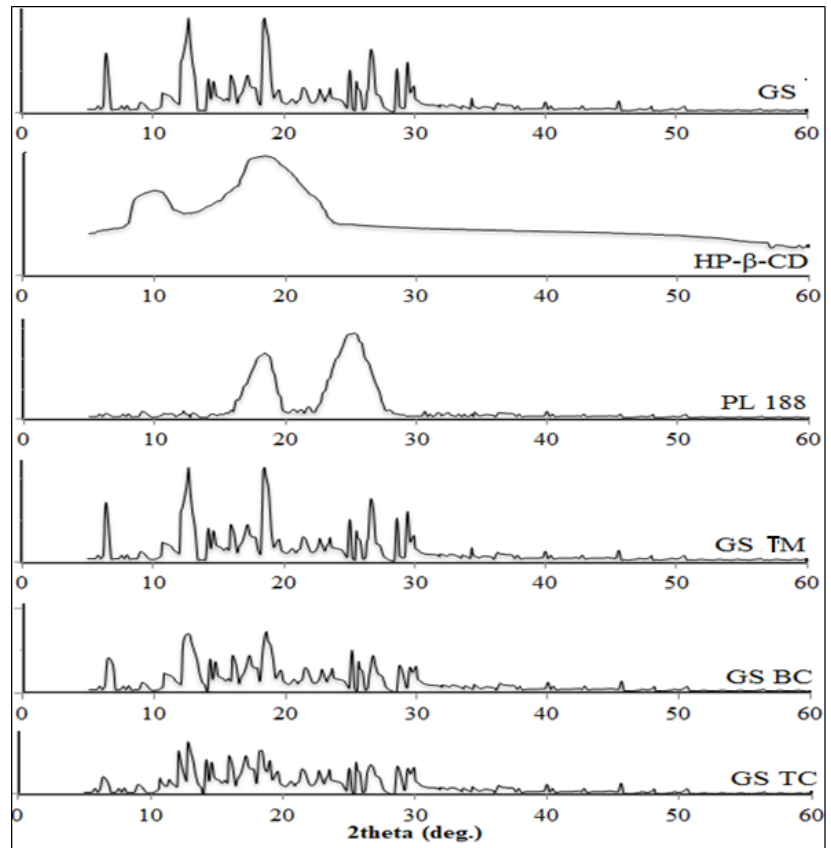
Figure 7. XRD spectra of Genistein, HP- β CD, poloxamer 188, genistein ternary mixture (GS TM), genistein binary complex (GS BC) and genistein ternary complex (GS TC). Table 2. NMR spectra value of pure genistein (GS), poloxamer 188 (PL 188), HP- β cyclodextrin (HP - β CD), genistein ter- nary mixture (GS-PM) and genistein ternary complex (GS-TC).